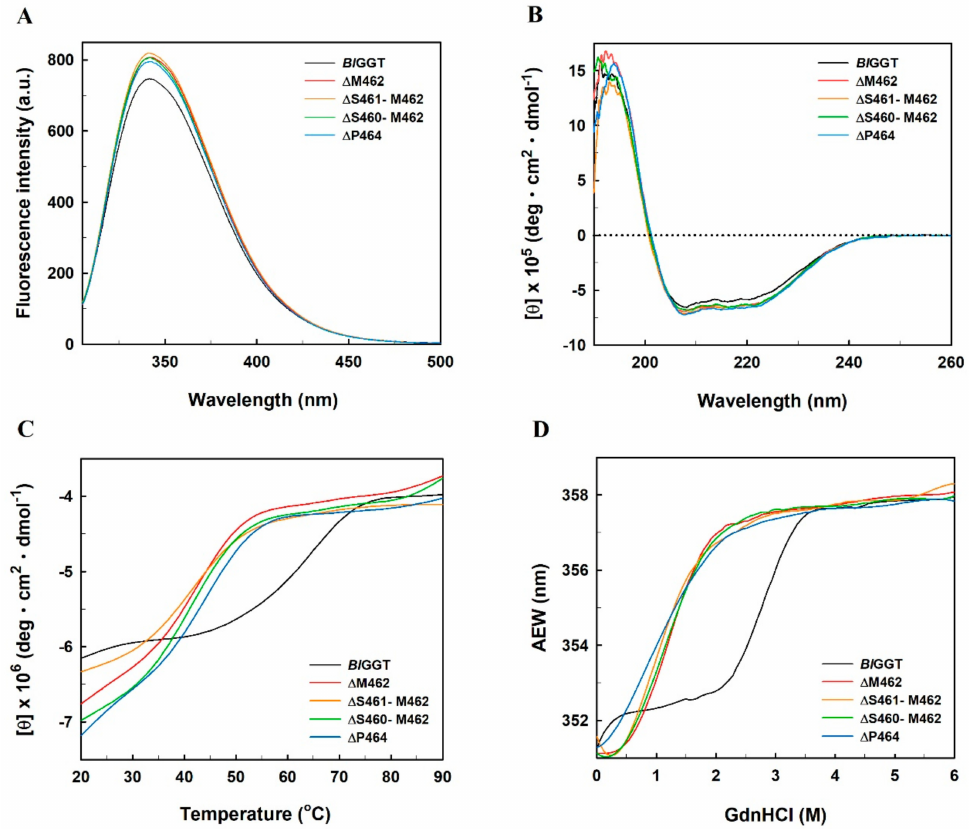
Figure 5. Spectroscopic analysis of the wild-type and deletion mutant enzymes. ( A ) Intrinsic fluorescence spectra of Bl GGT and its deletion mutants. The average of five spectra for each of the freshly prepared enzyme samples was recorded. ( B ) Far-UV spectra of Bl GGT and its deletion mutants. The data were recorded at 22 ◦ C and residual molar elliticities of Bl GGT and its deletion mutants in 25 mM Tris-HCl bu ff er (pH 9.0) were measured from 190 to 250 nm. ( C ) Temperature-induced denaturation of Bl GGT and its deletion mutants. The protein samples in 25 mM Tris-HCl bu ff er (pH 9.0) were monitored with the CD signal at 222 nm. ( D ) GdnHCl-induced denaturation of Bl GGT and its deletion mutants. GdnHCl-induced alterations in the tertiary structures of the freshly prepared enzyme samples were monitored by calculating their